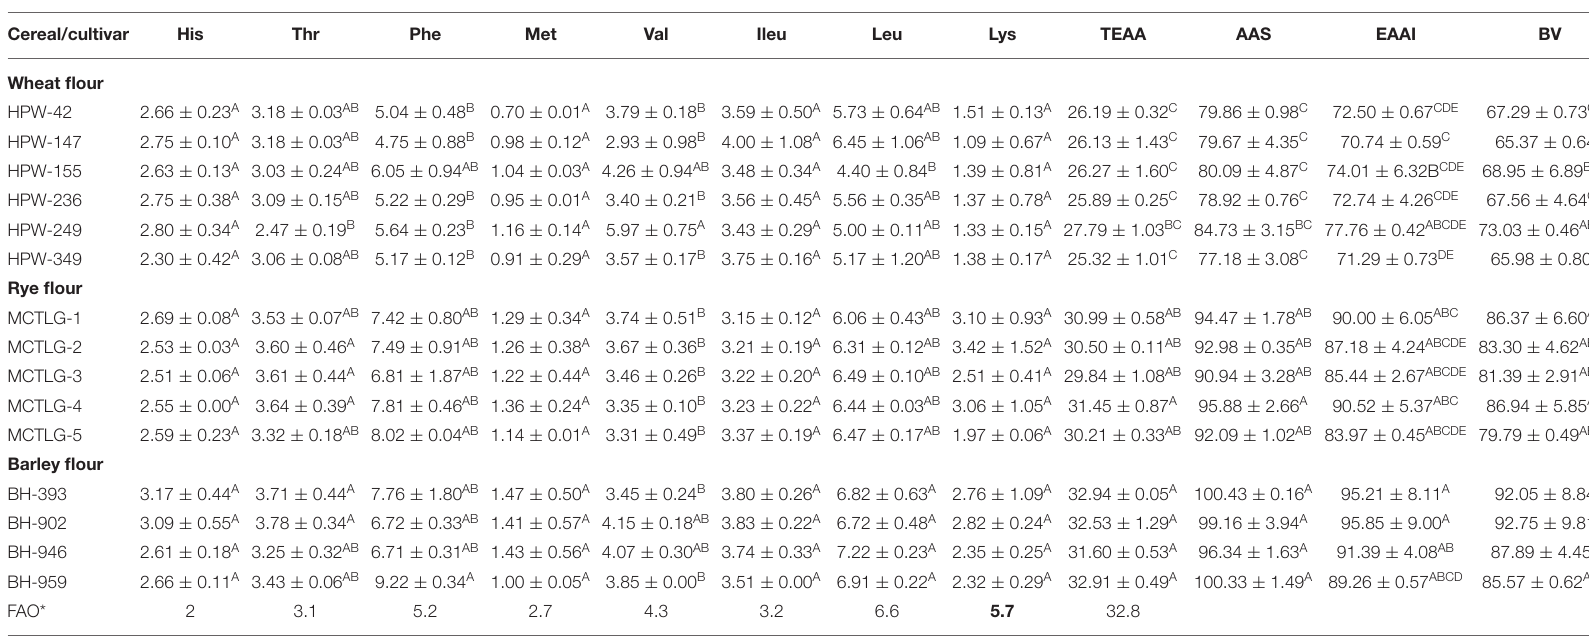
TABLE 5A | Essential amino acid (EAA) composition (g amino acid/100g protein) in flour of wheat, rye, and barley cultivars. Cereal/cultivar His Thr Phe Met Val Ileu Leu Lys TEAA AAS EAAI